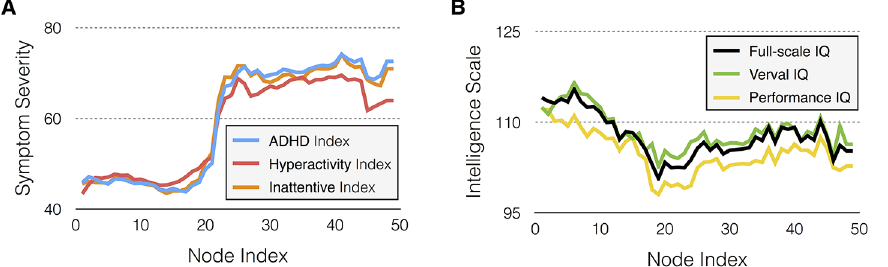
Fig 4. Visualization of the clinical phenotype data as a function of the node index in the NYU data. ( A ) Average symptom severity in each bin of graph. ( B ) Average intelligence scores in each bin of